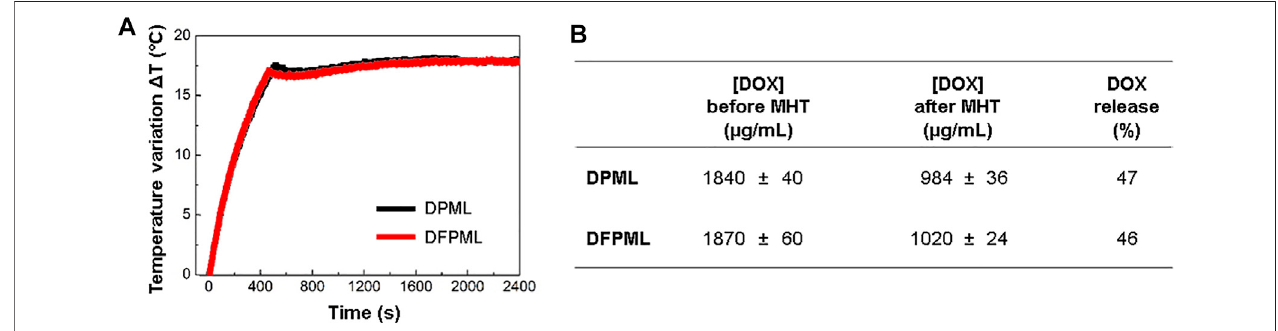
FIGURE3| MHT-mediated controlledreleaseofDOX. (A) MHTpro fi lesofDOX-loadednanocarriers (DPMLand DFPML).ACmagnetic fi eldfrequencyof334 kHz, and amplitudecontrolledtokeep thesampletemperatureat43 ° Cfor30 min (B) DOXconcentrationinDPMLand DFPMLbeforeand after MHT.Percentageofreleased DOX from DPML and DFPML, calculated via Eq. 4